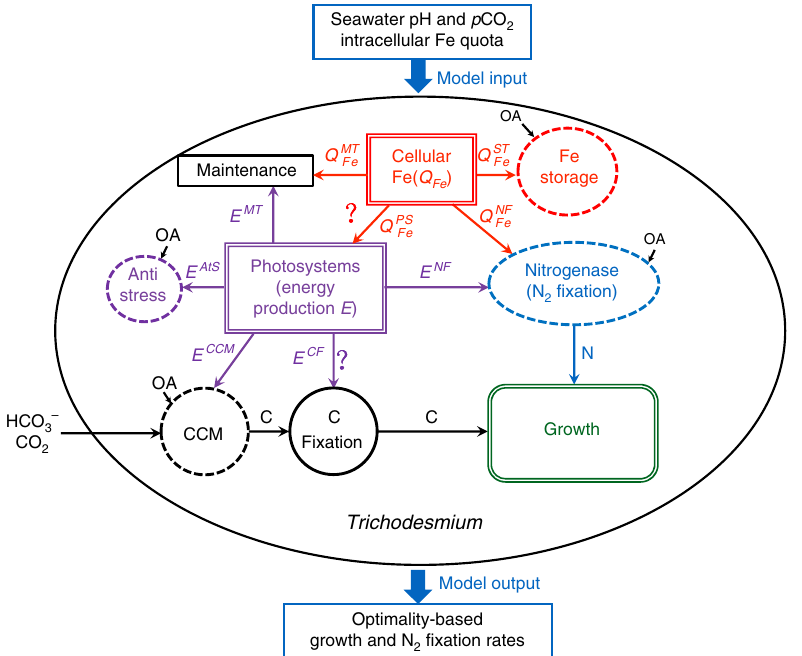
Fig. 1 Trichodesmium cellular model structure. The intracellular Fe (red) and produced energy (purple) are allocated to different cellular processes. The dashed circles and ellipses pointed by OA indicate processes that are in fl uenced by ocean acidi fi cation. The two fl ows with question mark represent unknown parameters to be optimized to maximize Trichodesmium growth